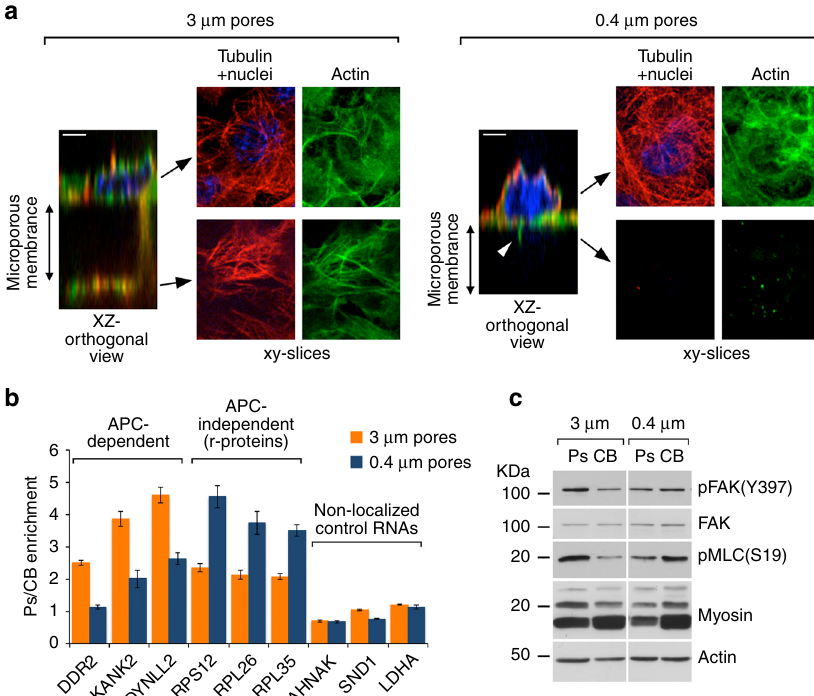
Fig. 2 APC-dependent and APC-independent RNAs are enriched in different types of protrusions, associated with high or low levels of contractility. a NIH/3T3 fi broblast cells were plated on microporous fi lters containing pores of 3 or 0.4 μ m in diameter. The cells were induced to extend protrusions by addition of LPA in the bottom chamber and were subsequently fi xed and stained to detect actin (green), tubulin (red), and nuclei (DAPI, blue). Confocal xy-slices through the cell body or protrusions, or xz-orthogonal views are shown. Scale bars: 4 μ m. b Ps and CB fractions were isolated from cells extending protrusions through 3 or 0.4 μ m pores. The indicated RNAs were detected through nanoString analysis to calculate Ps/CB enrichment ratios ( n = 3; error bars: standard error). c Ps and CB fractions, of cells extending protrusions through 3 or 0.4 μ m pores, were analyzed by western blot to detect the indicated proteins. Results are representative of two independent